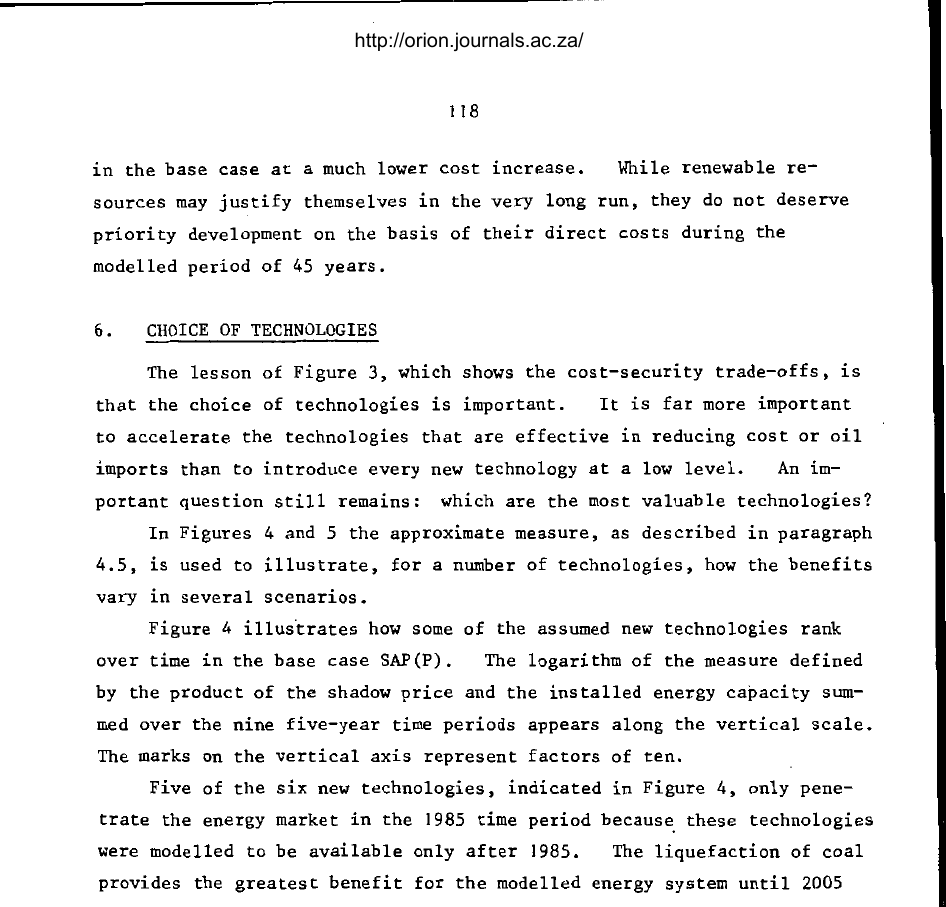
Figure 4 illus.trates how some of the assumed new technologies rank over time in the base case SAP(P). The logarithm of the measure defined by the product of the shadow price and the installed energy capacity sum med over the nine five-year time periods appears along the vertical scale. The marks on the vertical axis represent factors of